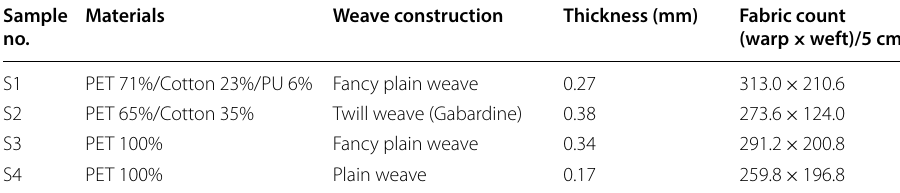
Table 1 Characteristics of 4 fluorescent fabric samples Sample